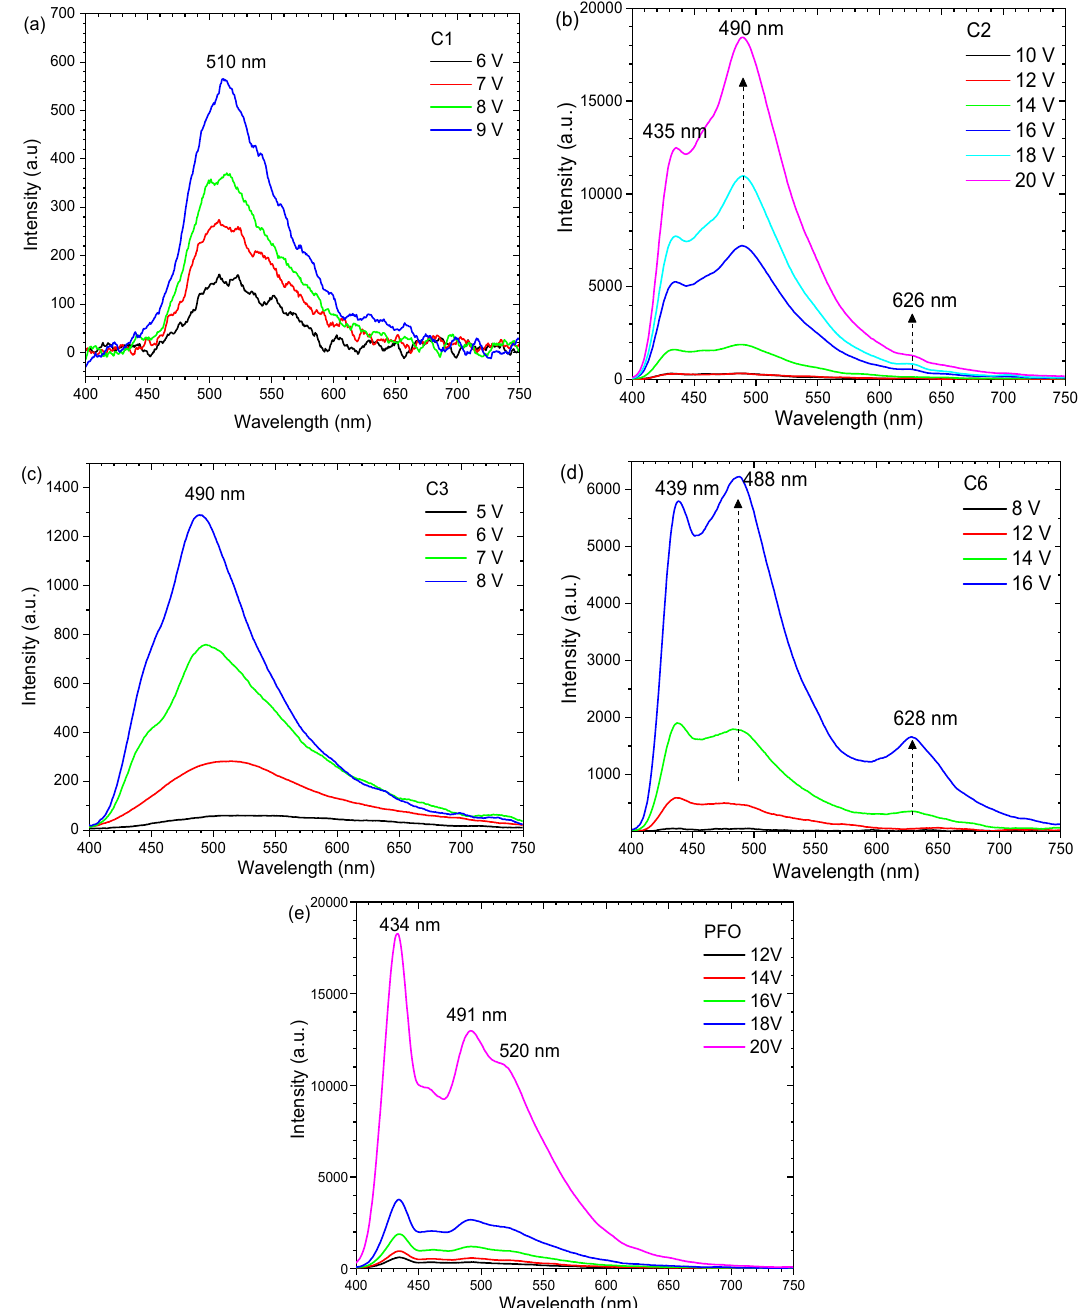
Figure 7. EL spectra of ( a ) C1, ( b ) C2, ( c ) C3, ( d ) C6 as compared to ( e ) PFO at di ff erent applied voltages. Two emissions peaks were observed for both C2 and C6 at 430 nm and 495 nm, while an additional peak at 520 nm was detected for PFO. The peak at 520 nm at the green emission band may be caused by oxidation e ff ects [17]. In the report, the e ff ects were stabilized by the presence of TPA in the polymer. The overall spectra width was broader than the PL spectra for these polymers. The intensity of PFO increased with applied voltage consistently without significant change in the spectral shape. However, for C2 and C6, the increase of the applied voltage induced changes to the spectral shape. For C2, the ratio of the intensity at 435 nm to 495 nm increased from when the voltage was increased from 10 V to 20 V. Another peak at 626 nm emerged when the applied voltage was 18 V. For C6, the ratio of the peak at 439 nm to 488 nm changed from 1:0.8 to 1:1.1, and another peak at 628 nm occurred above 14 V.